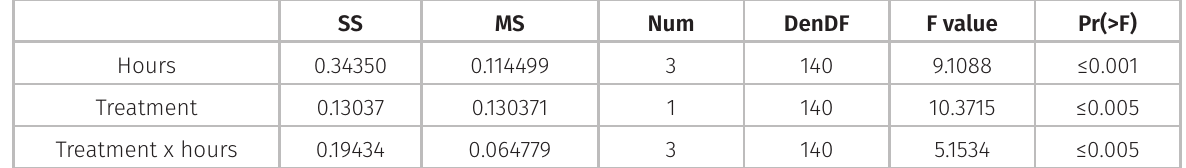
Figure 1. Box plot of the effect of the injection on the right posterior sole pad (PHA, treatment; black box) and on the left posterior sole pad (PBS, control; white box) in adult males of Liolaemus kingii performed to analyze the inflammatory responses during the experiment. The medians, 5%, 25%, 75% and 95% percentiles of the frequencies are indicated. Asterisks indicate significant differences between the treatment and control groups ( P < 0.05). The letters indicate the differences among the four treatment groups: previous, 2h, 20h, and 48h after the injection of PHA ( P <